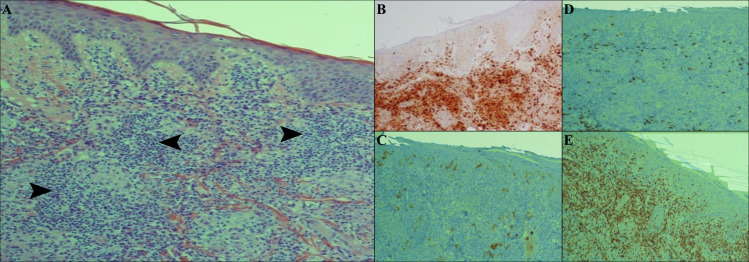
Histopathological and immunohistochemical findings in chronic form.A) H & E staining shows histopathological changes of dense and diffuse lymphohistiocytic infiltrate (arrowheads) in the dermis, B) aggregation of histiocytes by CD68 IHC staining, C) haphazard distribution of Langerhans cells in epidermis and dermis by CD1a IHC staining, D) presence of few infiltrate of positive B lymphocytes by CD 20 IHC staining, E) heavily infiltrate of CD3 T-lymphocytes between histiocytes.